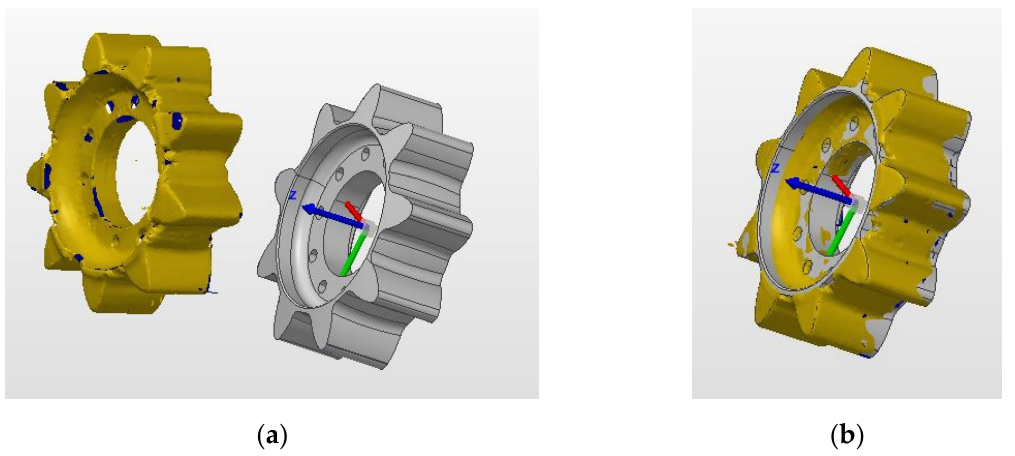
Figure 2. CAD and scanned models ( a ) before registration ( b ) after rigid registration using ICP algorithm [33].